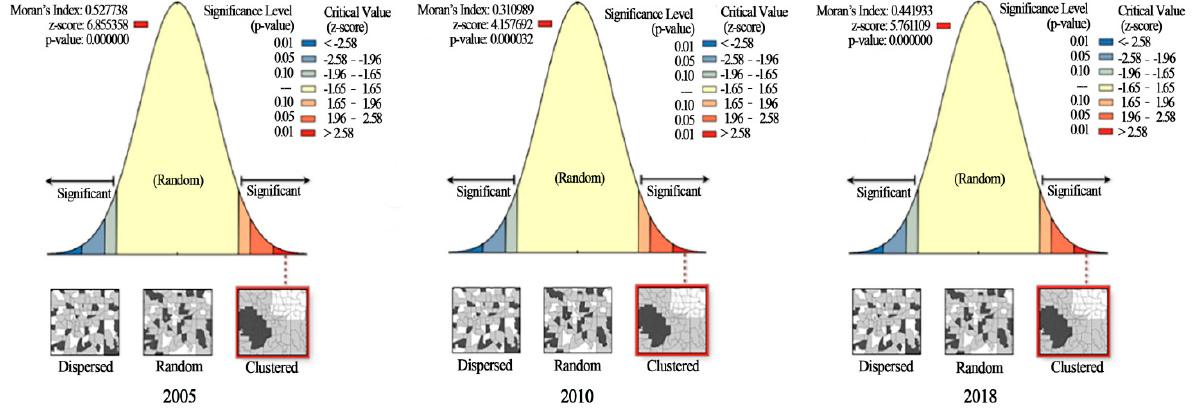
Figure 7. Spatial agglomeration of the CCD of CLUB from 2005 to 2018.